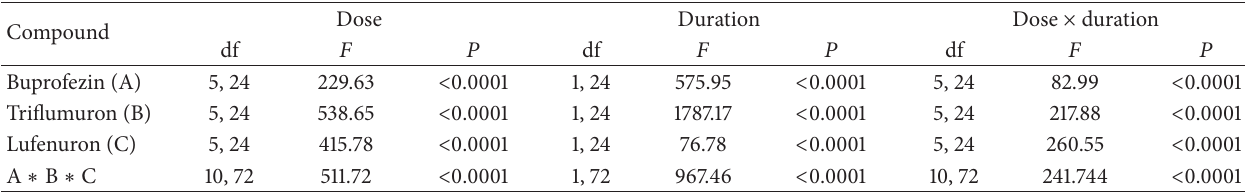
Table 4: ANOVA results on the acetylcholinesterase (AChE) responses of mature earthworms ( A. caliginosa ) exposed to buprofezin, triflumuron, and lufenuron contaminated artificial